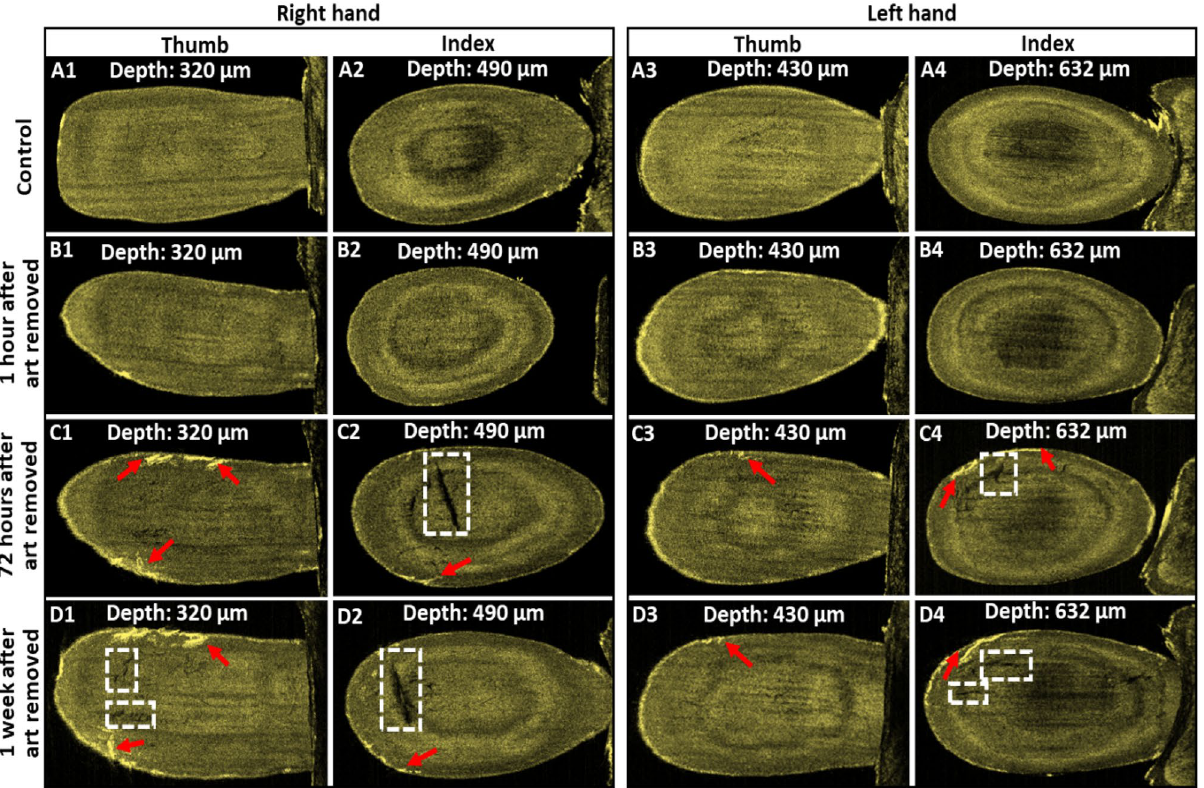
Figure 7. Enface images of control and art-removed nails of right and left hands. Images 7 ( A1 – A4 ) enface images of control thumb, and index fingernails of the right and left hands. Images 7 ( B1 – B4 ) enface images of thumb, and index fingernails of the right and left hands after 1 h of nail-art removal. Images 7 ( C1 – C4 ) enface images of thumb, and index fingernails of the right and left hands after 72 h of nail-art removal. Images 7 ( D1 – D4 ) enface images of thumb, and index fingernails of the right and left hands after 1 week of nail-art